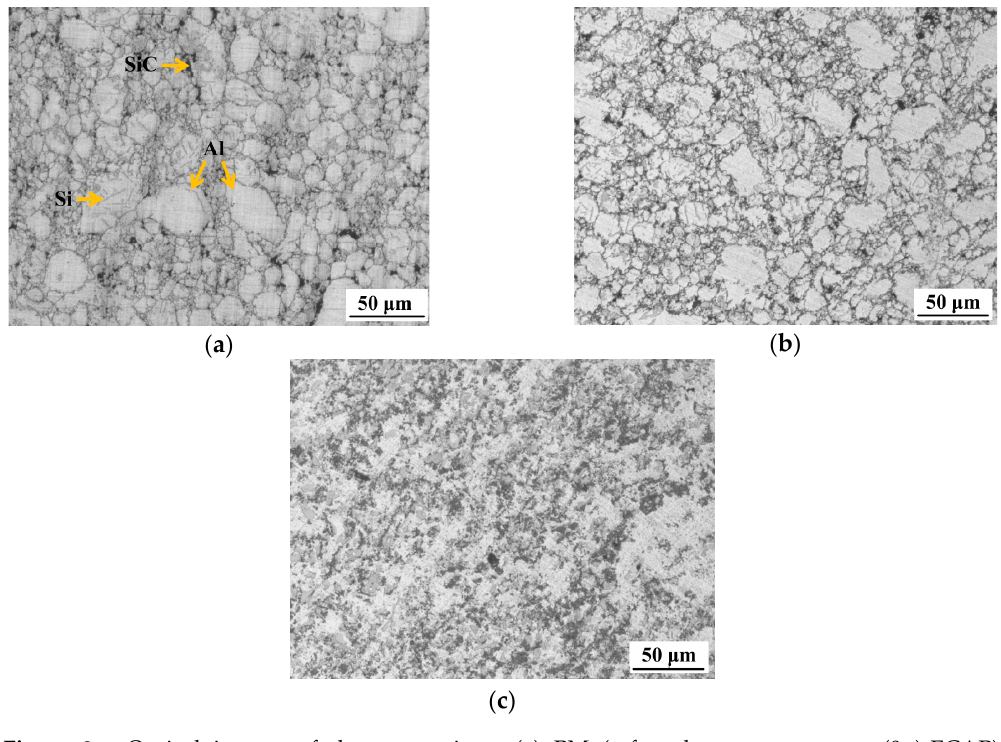
Figure 3. Optical images of the composites: ( a ) PM (referred to as zero pass (0p)-ECAP), ( b ) PM-4p-ECAP and ( c ) PM-8p-ECAP.